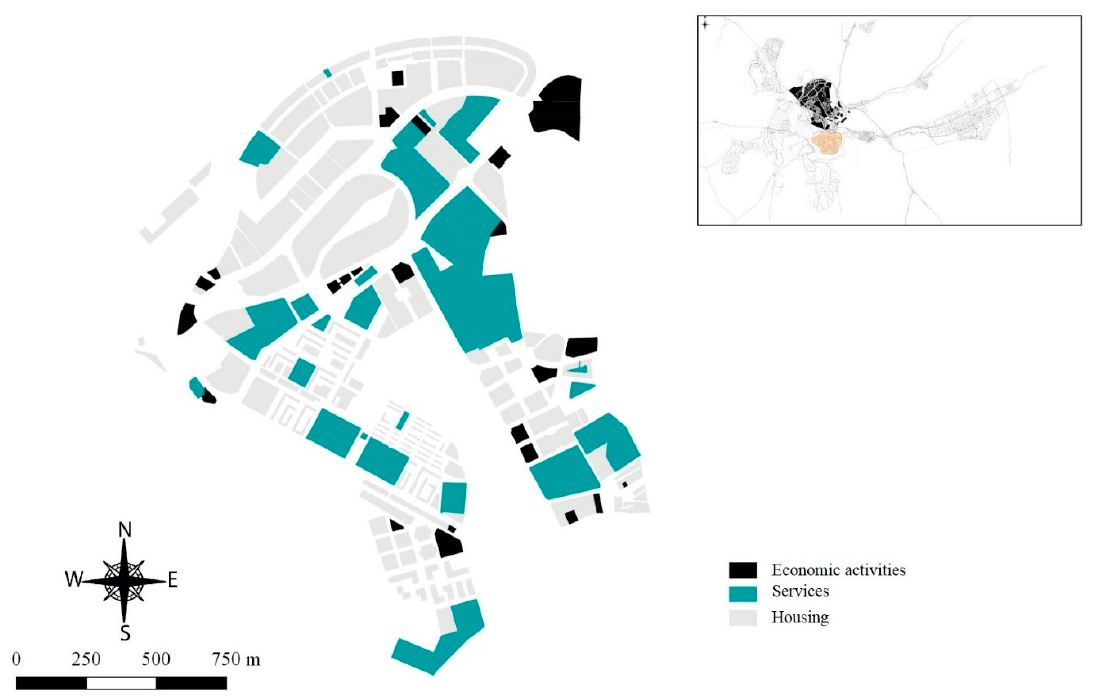
Figure 7. Main uses of the soil of the Ensanche of Toledo. Source: self- elaboration from Cartociudad [68] and the Land Registry [64].